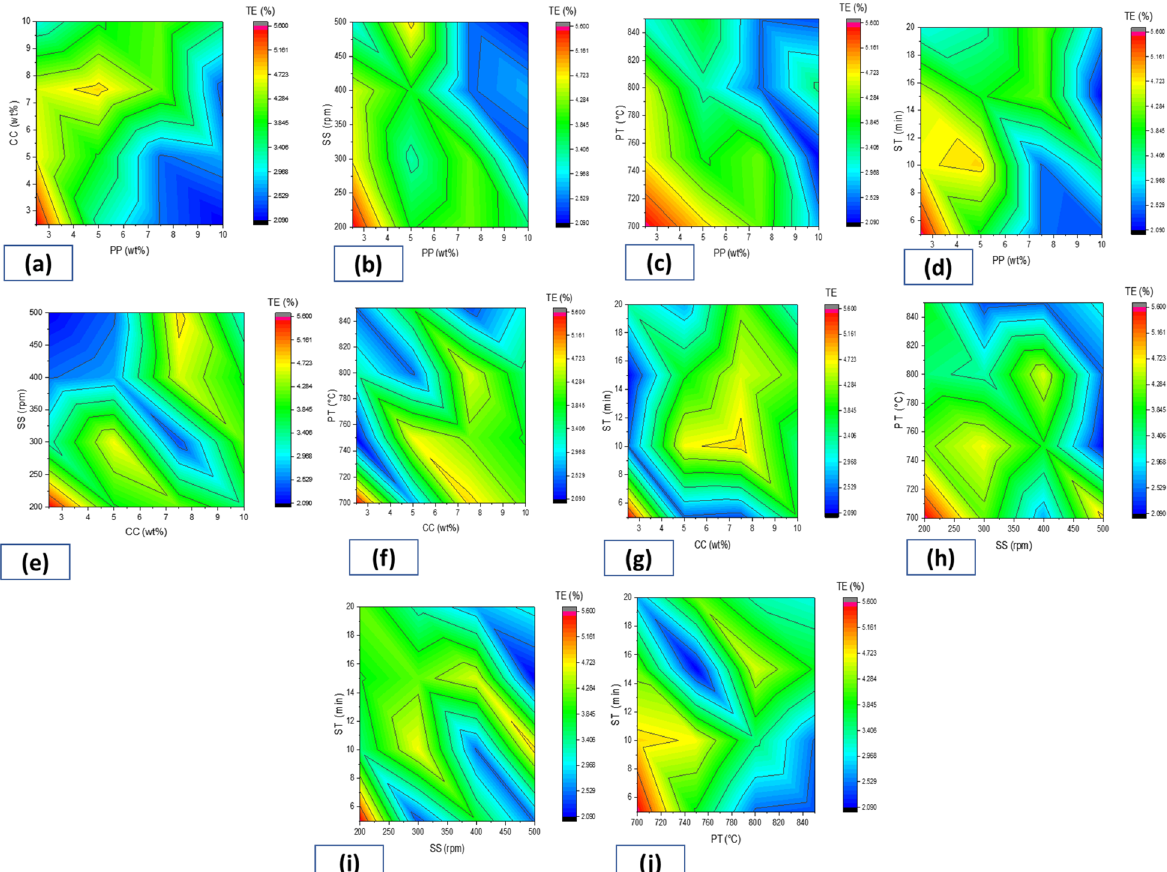
Figure 6. Interaction Contour Plots of Percentage Elongation (PE) with Process Parameters at Various Reinforcement Addition: ( a ) PE vs.CC, PP, ( b ) PE vs. PT, PP, ( c ) PE vs. SS, PP, ( d ) PE vs. ST, PP, ( e ) PE vs. SS, CC, ( f ) PE vs.PT, CC, ( g ) PE vs.ST, CC, ( h ) PE vs. PT, SS, ( i ) PE vs. ST, SS, ( j ) PE vs. PT,